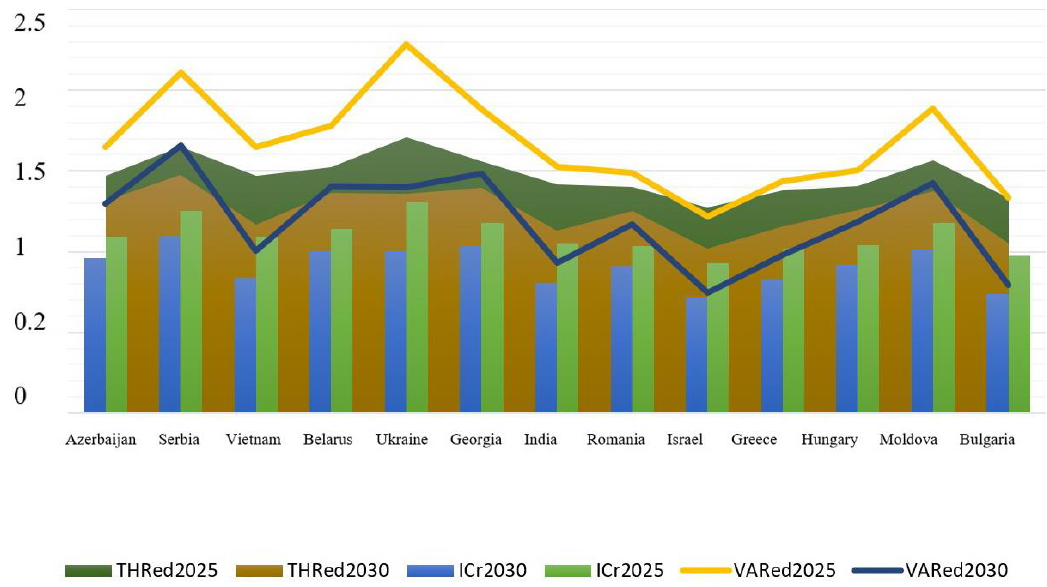
Figure 8. Energy dependence forecasts up to 2025 and 2030 for the most energy-dependent countries. Source: developed by the authors.